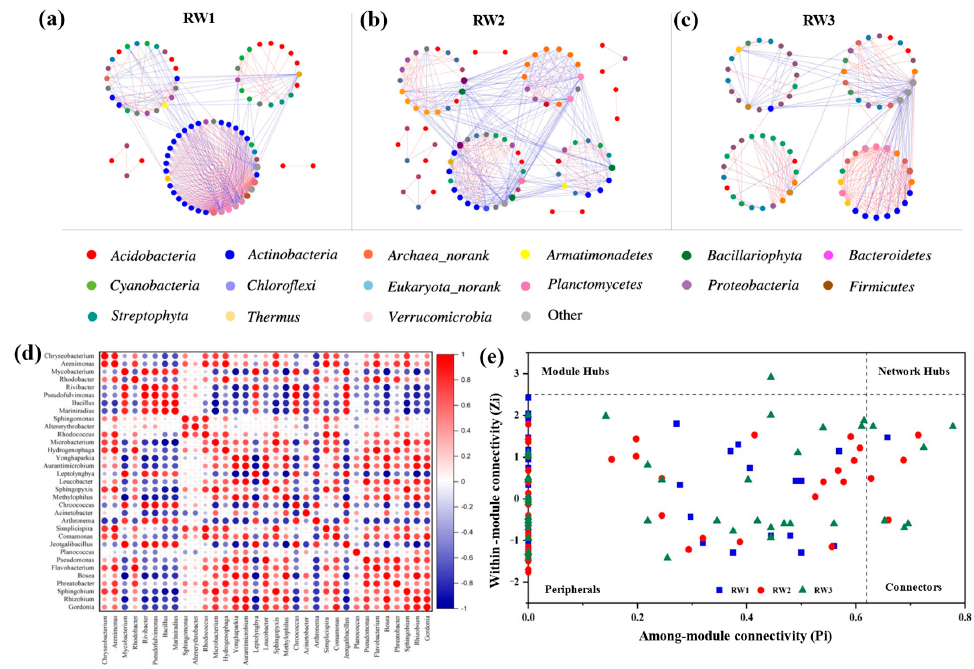
Figure 5. Interaction of bacterial networks in biofilms. ( a – c ) Visual co-occurrence networks of microbes in biofilms formed by RW1, RW2, and RW3, respectively. Red links indicate negative connections and blue links indicate positive connections between the OTUs; ( d ) Spearman correlation analysis among different bacterial genera (top 33). Each circle’s diameter and color are proportional to the correlation coefficients, and blue represents negative correlation while red represents positive correlation; ( e ) Zi-Pi plots based on the topologic roles under different water sources.